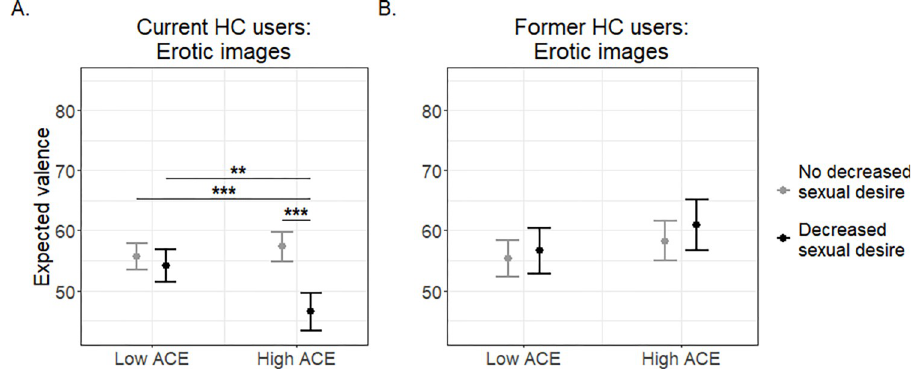
Fig 3. Interaction of prepubertal adverse childhood experiences (ACEs) group and self-reported decrease in sexual desire attributed to hormonal contraception (HC) use on expected valence ratings of erotic images. A: Current HC users who either endorse a decrease in sexual desire related to HC use or do not. B: Former HC users who either endorse having stopped using HC due to a decrease in sexual desire or discontinued due to other reasons. Only women currently using HC showed a significant interaction of ACE group by HC-related decreased sexual desire on expected valence ratings of erotic images ( p = 0.008 ) . This effect is driven by the fact that high ACE women who report experiencing decreased sexual desire on HC show a substantially lower anticipated valence of erotic images than the other three groups of current HC users ( �� p = 0.010, ��� p < 0.001).